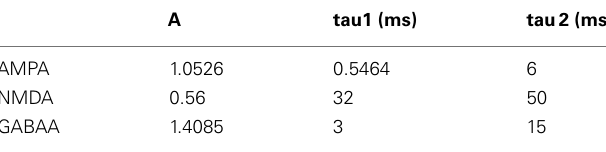
TableA3 | Synaptic current parameter values .